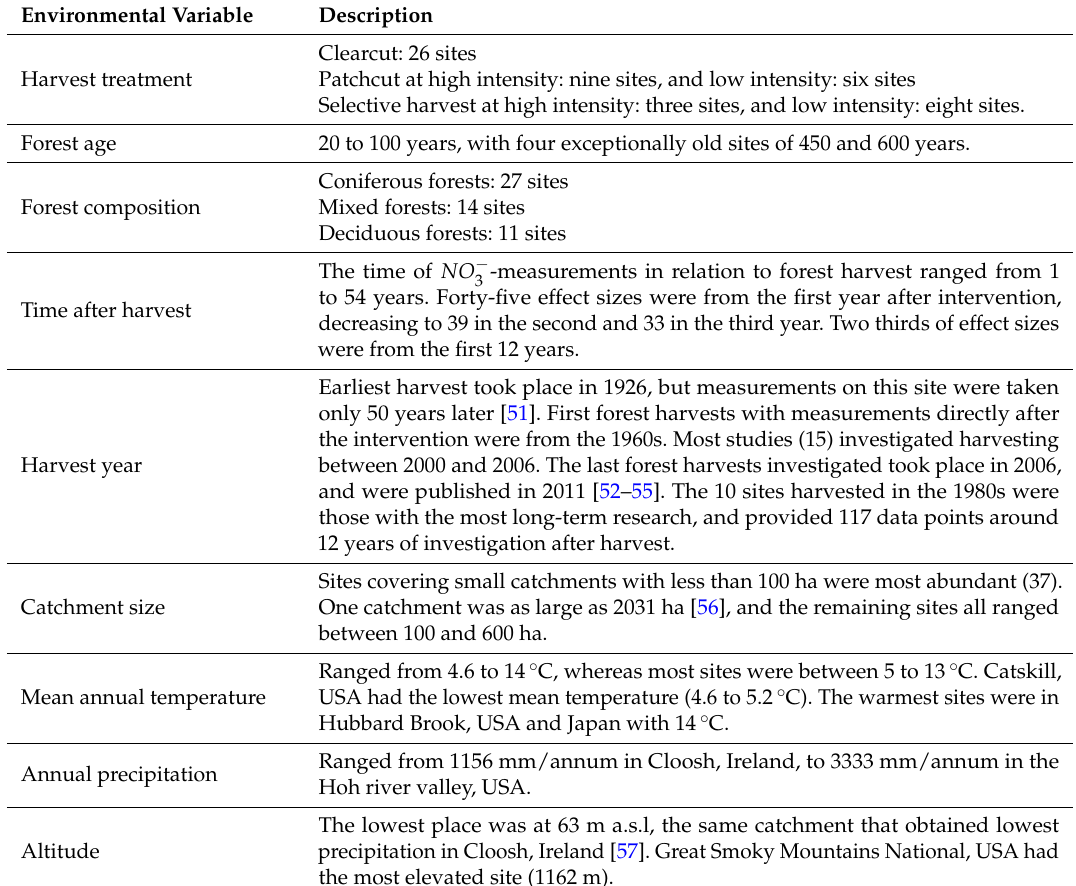
Table 1. Environmental variables used as predictors in the additive mixed model before model selection.